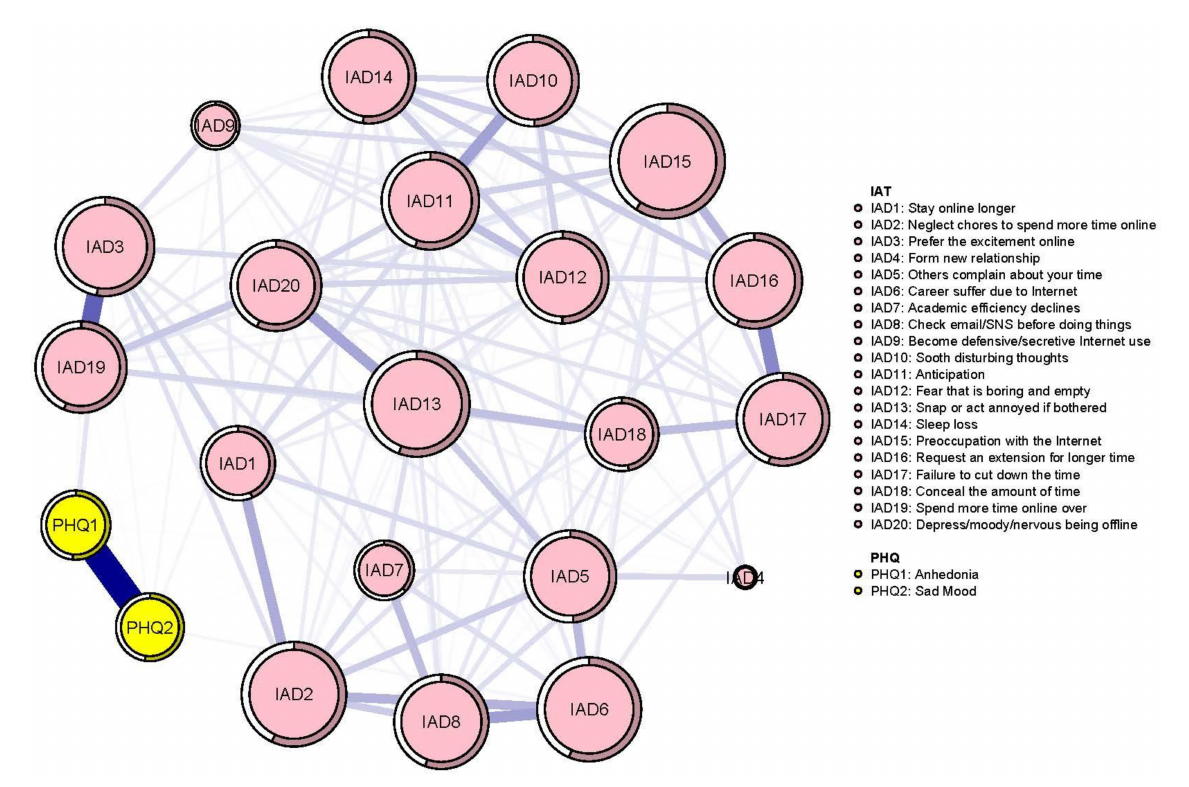
FIGURE1 Network of residual depressive symptoms and internet addiction.